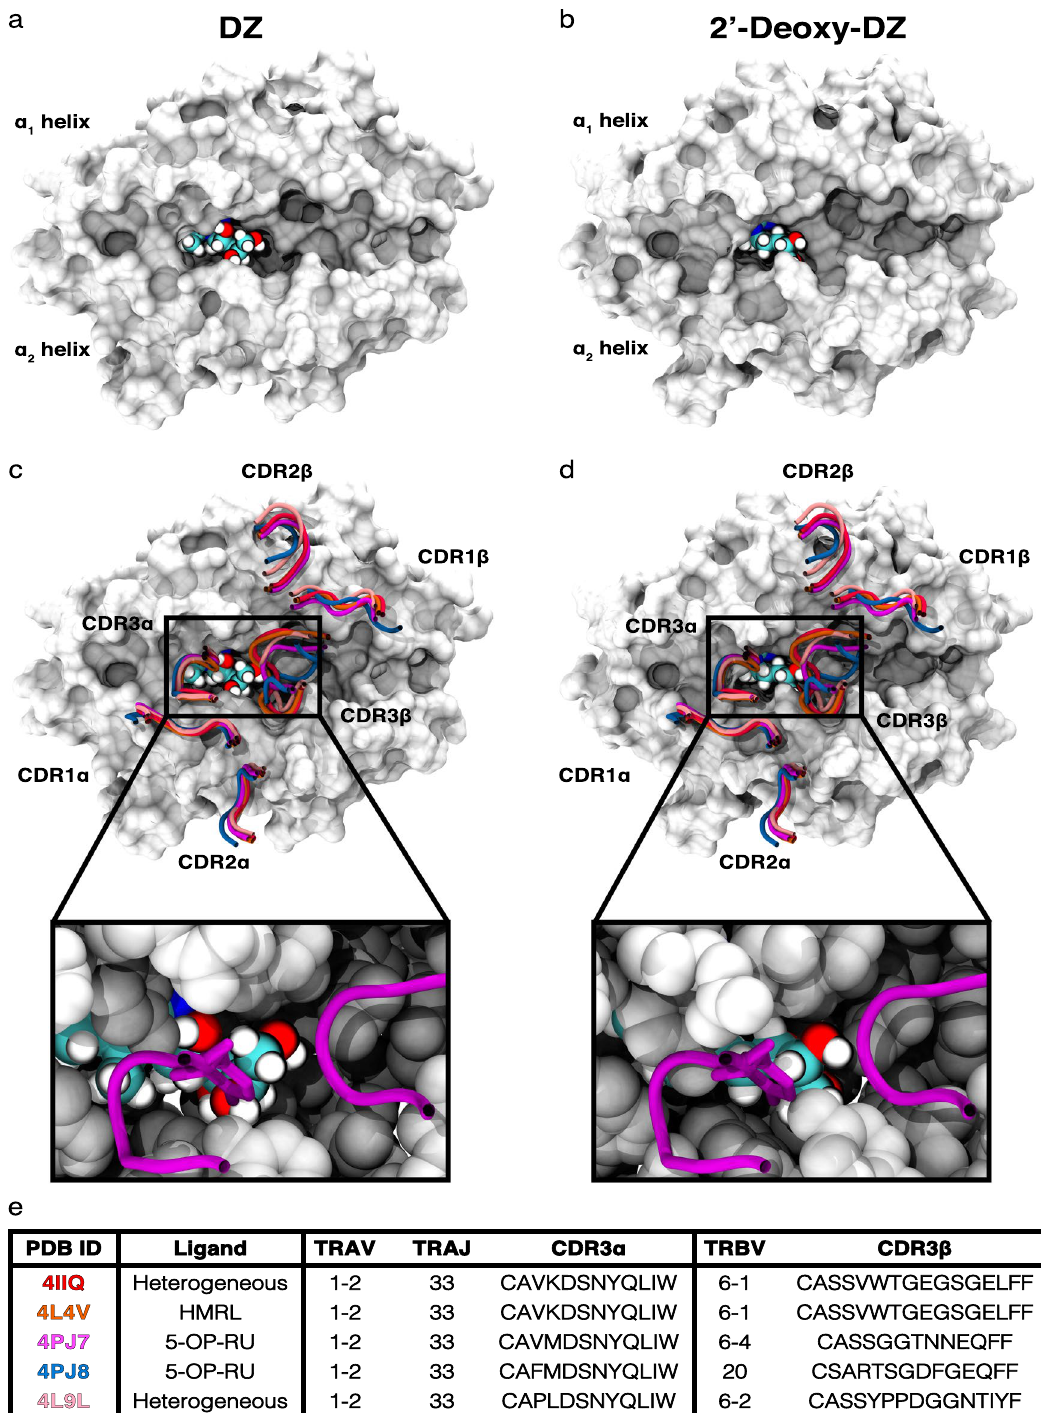
Figure 7. Visualizations of DZ and 2 ′ -deoxy-DZ orientation in MR1, and their proximity to the TCR. ( a , b ) DZ ( a ) and 2 ′ -deoxy-DZ ( b ) ligand orientation at the 25th frame of a representative simulation; the MR1 α1/α2 platform is represented as a surface and the ligand is represented by van der Waals-radius spheres. ( c , d ) Overlay of MAIT TCR CDR loops with the selected frame from DZ ( c ) and 2 ′ -deoxy-DZ ( d ). The inset is a zoomed-in representation of a TCR (PDB ID: 4PJ7) with the sidechain of Y95 shown explicitly. This is meant as a visual guide to aid in discussion of differential TCR interactions with